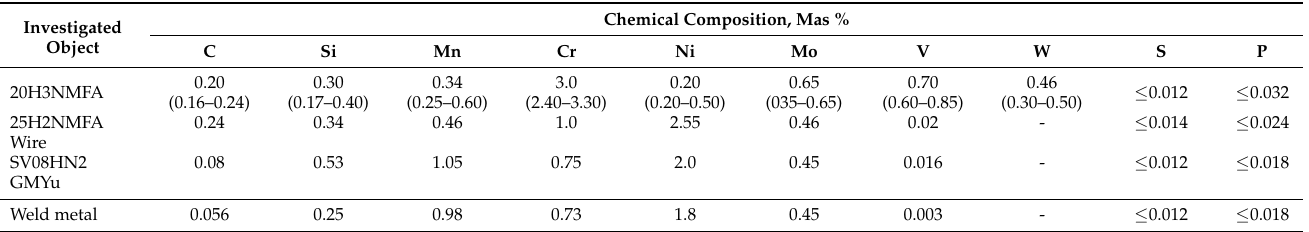
Table 1. Chemical composition of the base metal, electrode wire and weld metal of the combined weld